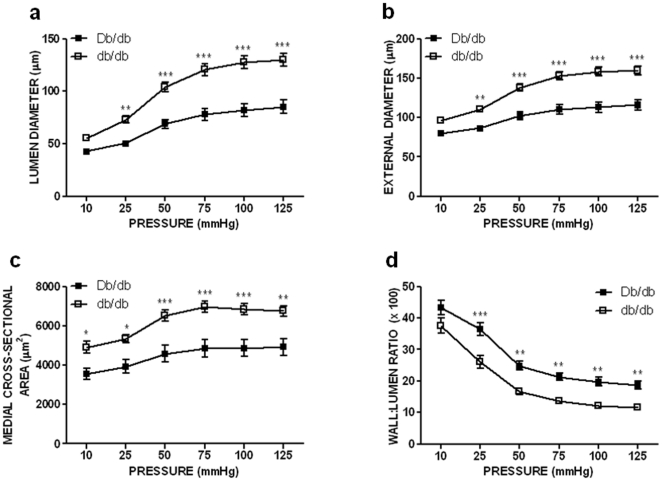
Lumen diameter (77.9±5.6 vs 120.6±5.5 µm at 75 mmHg, p<0.001), external diameter (110.4±6.4 vs 153.1±5.2 µm at 75 mmHg, p<0.001) and media cross-sectional area (4860.4±464.7 vs 6972.4±272.1 µm2 at 75 mmHg, p<0.001) were increased in 16 wk-old db/db MRAs while wall:lumen ratio (21.3±1.2 vs 13.7±0.8 at 75 mmHg, p<0.01) was decreased when compared to Db/db mice under physiological pressures of 50, 75 and 100 mmHg: a. Lumen diameter, b. external diameter, c. cross-sectional area, d. wall:lumen ratio.Two-way ANOVA: Db/db vs db/db, * p<0.05 ** p<0.01 *** p<0.001, means ± SEM; n = 8 for each group.